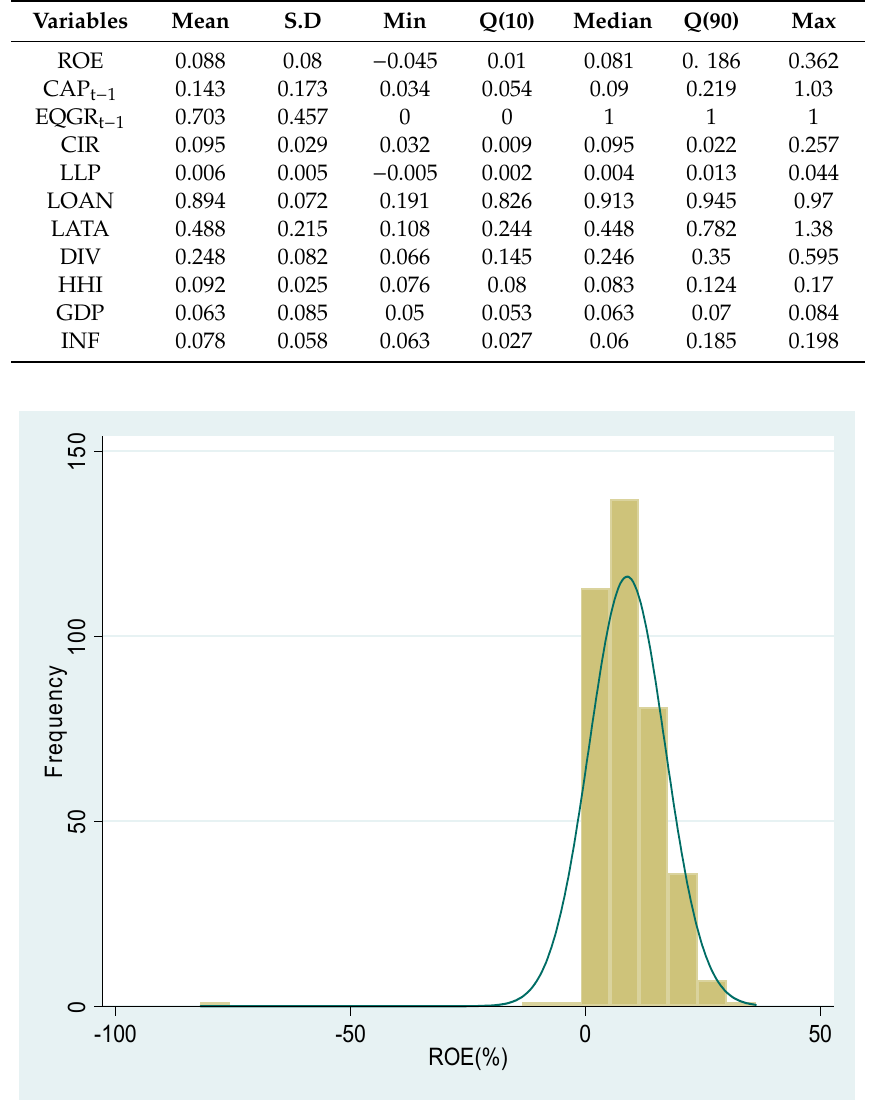
Table 2. Descriptive statistics of the variables used.